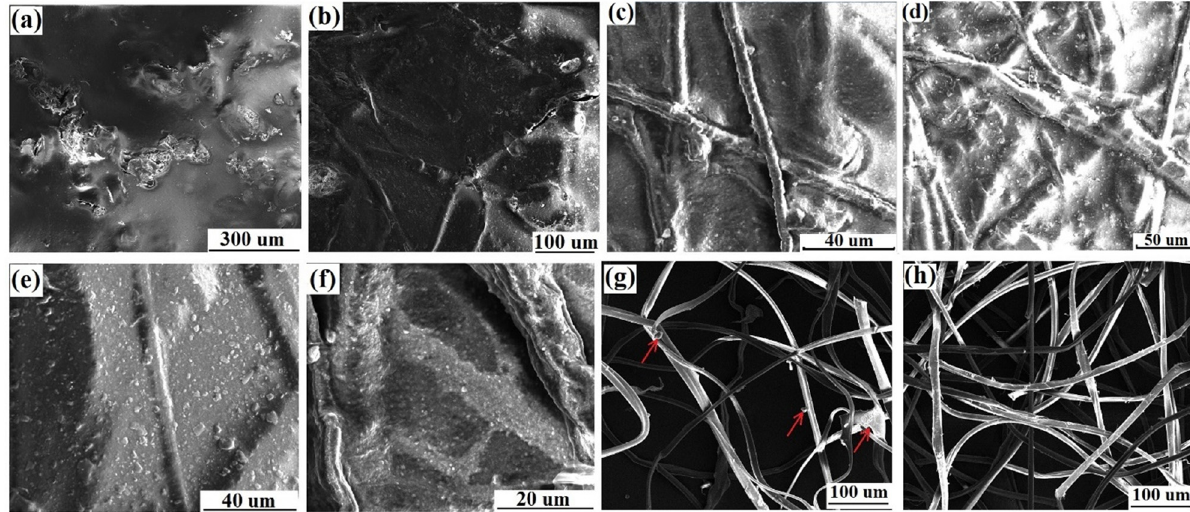
Figure 2: SEM micrographs of the composite membranes: ( a ) CS/n - HA ( 6:2 ) , ( b ) SF/CS/n - HA ( 1:6:2 ) , ( c ) SF/CS/n - HA ( 2:6:2 ) , ( d ) SF/CS/n -